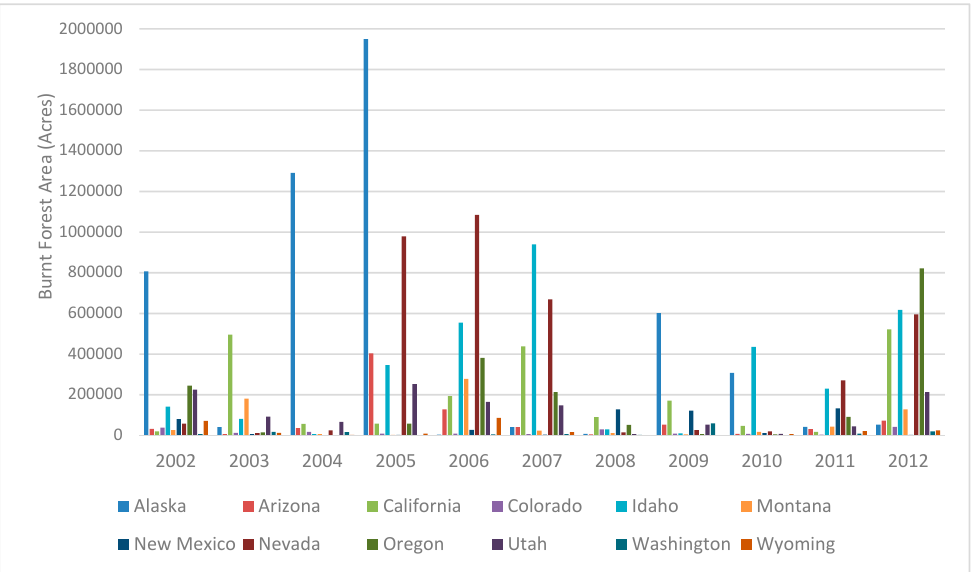
Figure 1. BLM fire data by state in the period 2002–2012. Source: Bureau of Land Management (BLM) of the US.